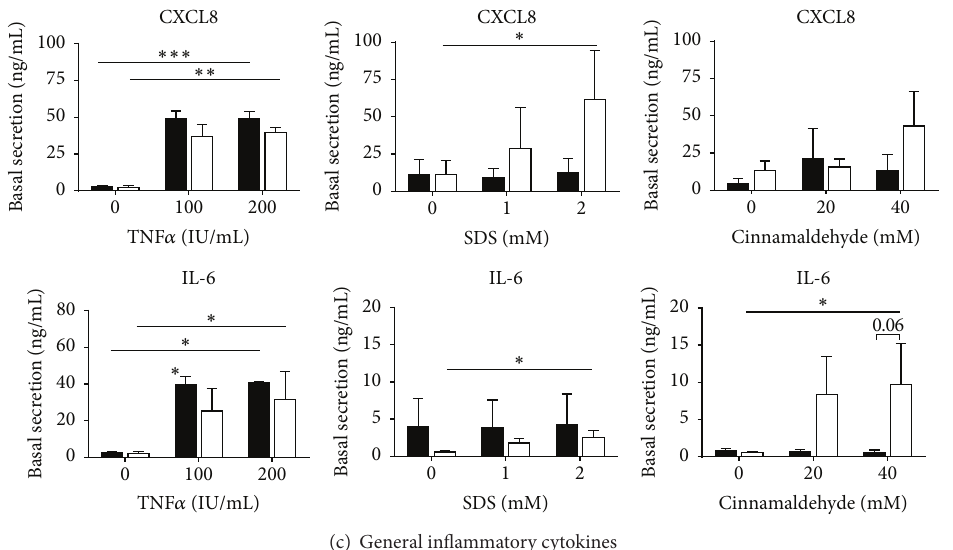
(c) General inflammatory cytokines Figure 4: Differential cytokine and chemokine secretion by skin and gingiva equivalents in response to rhTNF 𝛼 , irritant SDS, and allergenic cinnamaldehyde. (a) Proinflammatory cytokine secretion; (b) Langerhans cell (LC) migration related chemokine secretion; (c) general inflammatory cytokine secretion. Cultures were unexposed or exposed to rhTNF 𝛼 (culture medium exposure; 100 and 200 IU/mL), SDS (topical exposure; 1 and 2mM), or cinnamaldehyde (topical exposure; 20 and 40 mM) for 24 h. Cytotoxicity as assessed by MTT assay was < 20% at the highest chemical concentration. Culture supernatants were collected and analysed by ELISA. Data represent the average of at least 3 individual experiments ± SEM; ∗ 𝑝 < 0.05 ; ∗∗ 𝑝 < 0.01 ; ∗∗∗ 𝑝 < 0.001 ; paired Student’s 𝑡 -test for intraskin and intragingiva comparisons, unpaired Student’s 𝑡 -test for skin versus gingival